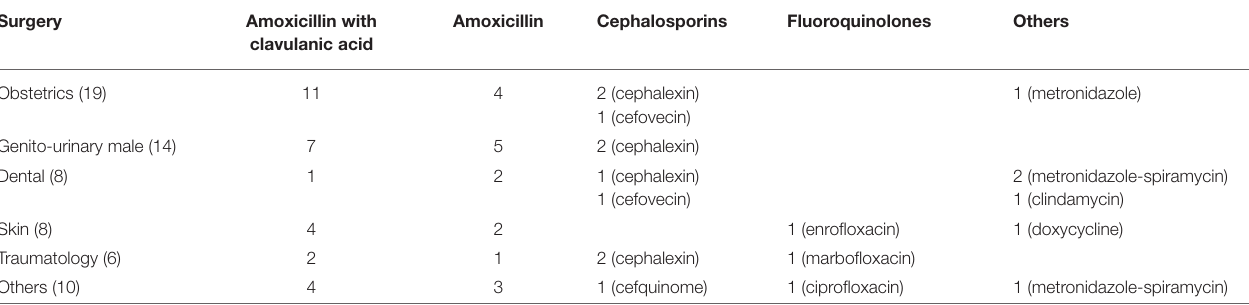
TABLE 5 | Distribution of antimicrobials of 65 medicinal products for perioperative use according to type of surgery. Surgery